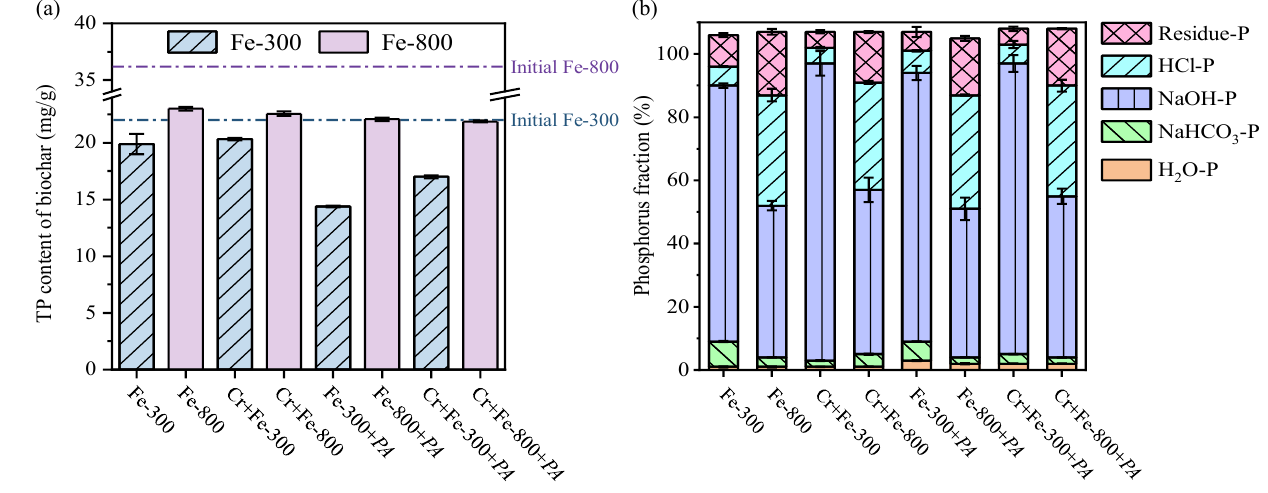
Figure 4. Changes in ( a ) total phosphorus concentration and ( b ) different phosphorus species on the 20th day.